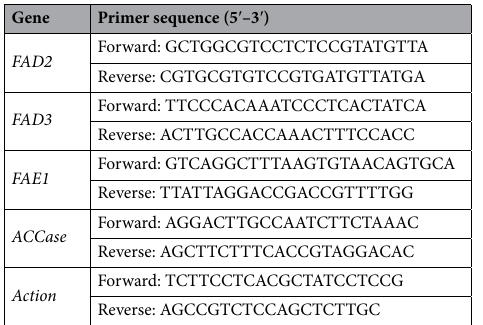
Table 1. The RT-q PCR primers of gene of the enzymes related to fatty acid biosynthesis.